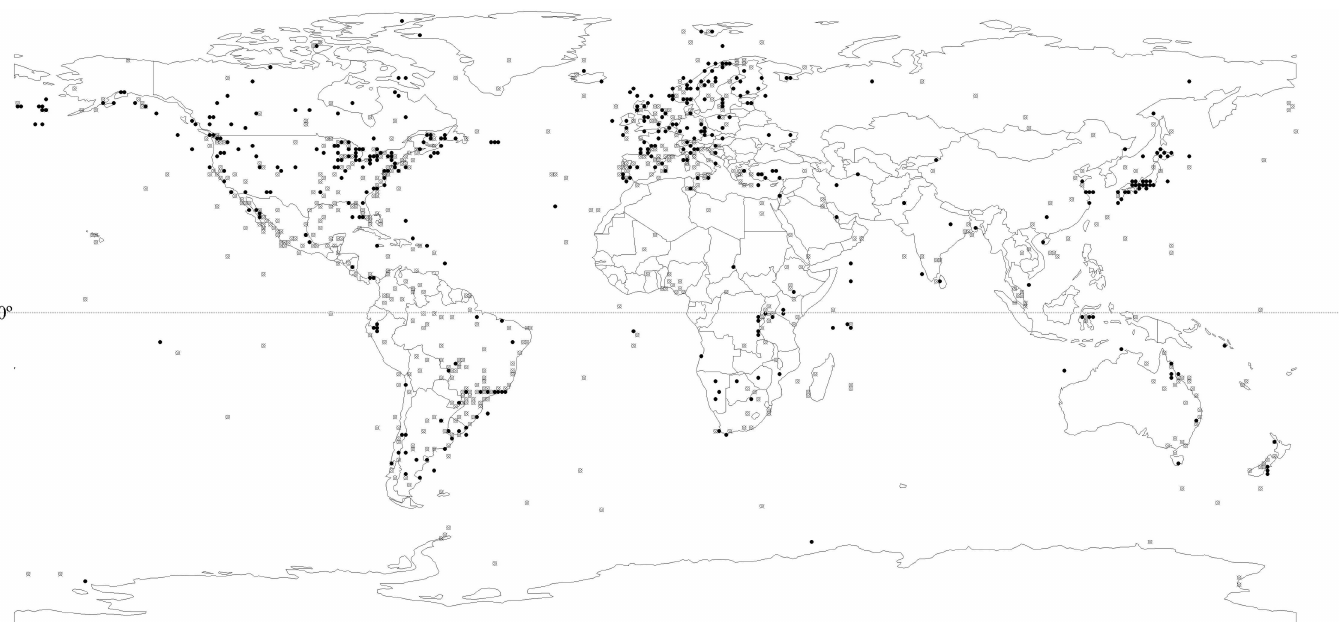
Fig 2. The global distribution of cannibalism occurrence based on a survey of 1,270 literature sources. Points represent the geographical coordinates of each study includedin the literaturereview. Black dots represent studies reportingcannibalism and opendots denote absenceof reported cannibalism. To avoid overlappingpoints, 234 coordinates were not plotted, including 134 for absenceand 100 for presence of